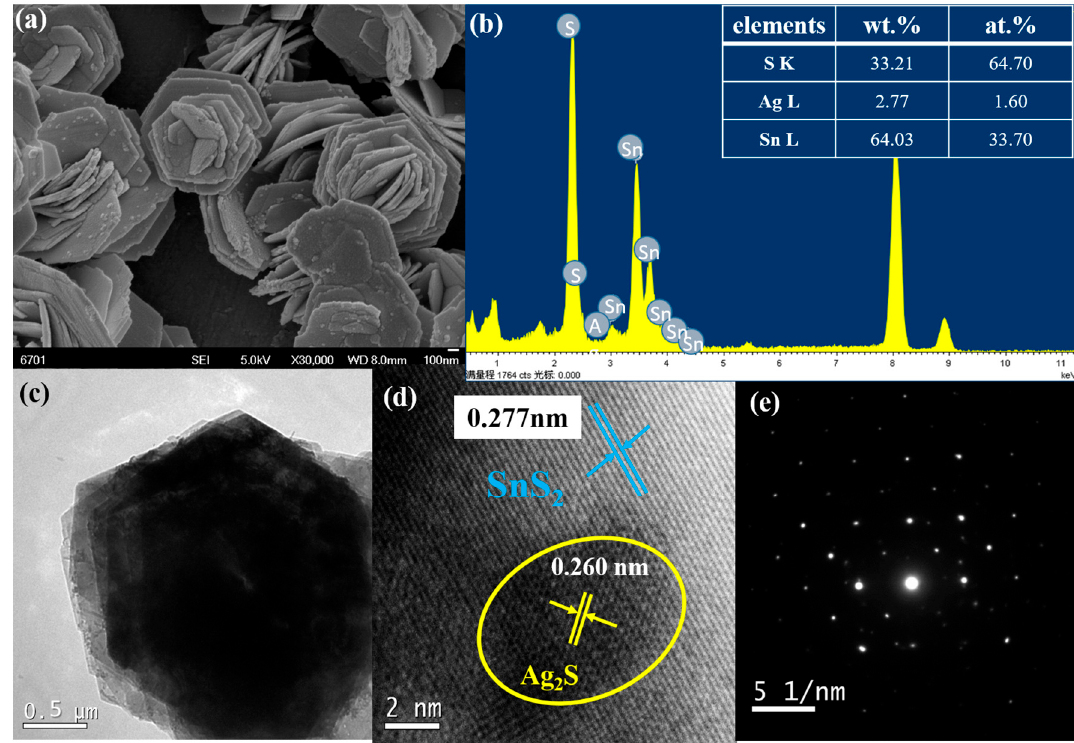
Figure 2. The scanning electron microscope images ( a ), X-ray energy dispersive spectrum ( b ), high resolution transmission electron microscope and selected electron diffraction pattern ( c – e ) of 3% Ag 2 S@SnS 2 composite.